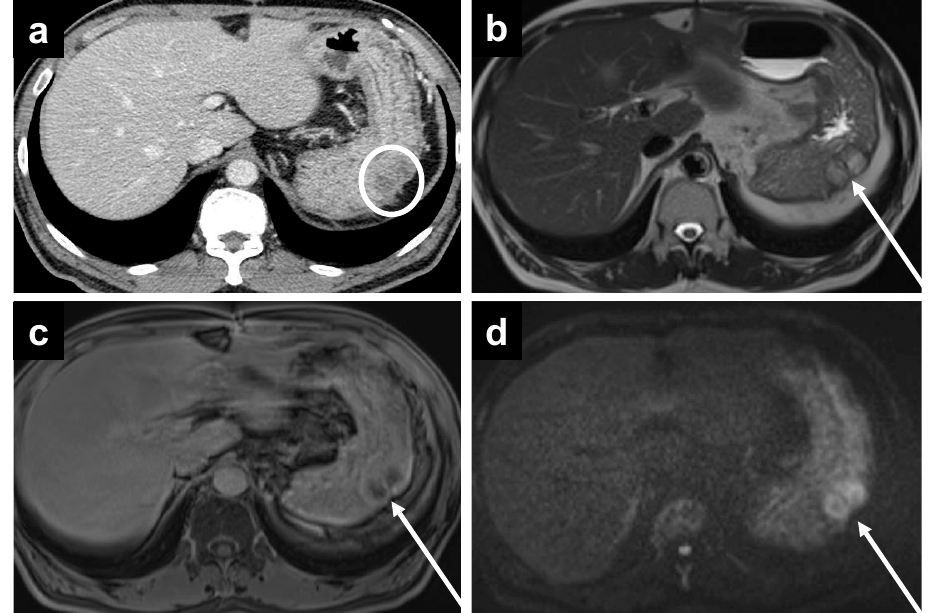
Figure 5. A 67-year-old male with metastatic colonic adenocarcinoma and gastric serosa peritoneal deposits. The deposits are not as well seen on ( a ) CT, as denoted by the white circle, but are more apparent on MRI, including the ( b ) T2W, ( c ) delayed, and ( d ) DWI sequences secondary to the superior soft tissue contrast.